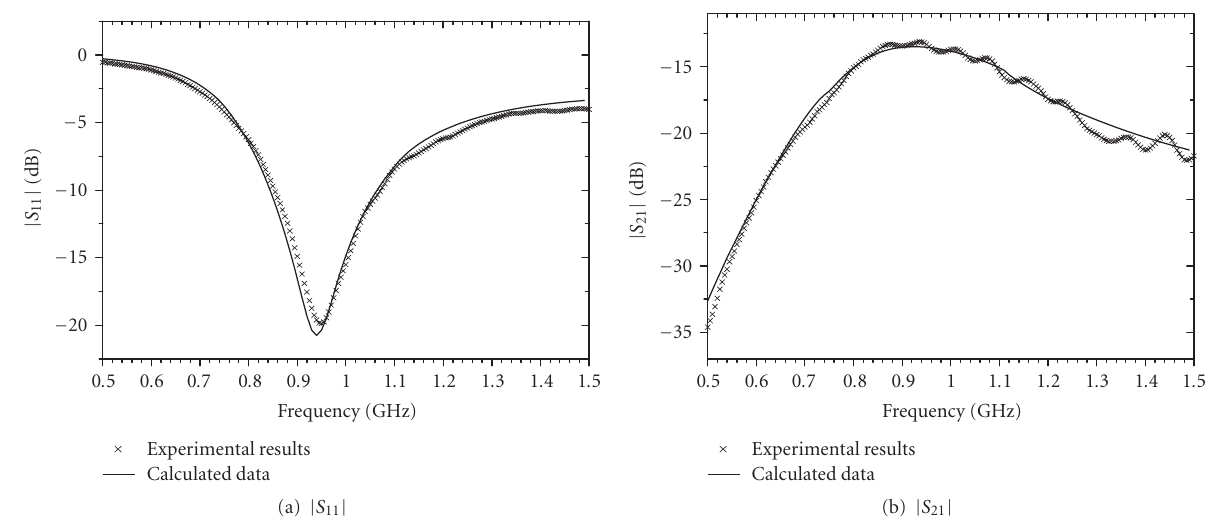
Figure 3: Simulated and measured S -parameters of the two-monopole antenna ( D = 160mm).